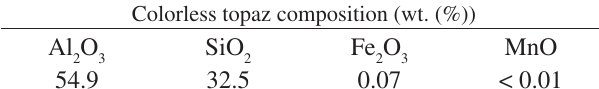
Table 1. Chemical composition of the colorless topaz. Colorless topaz composition (wt. (%))